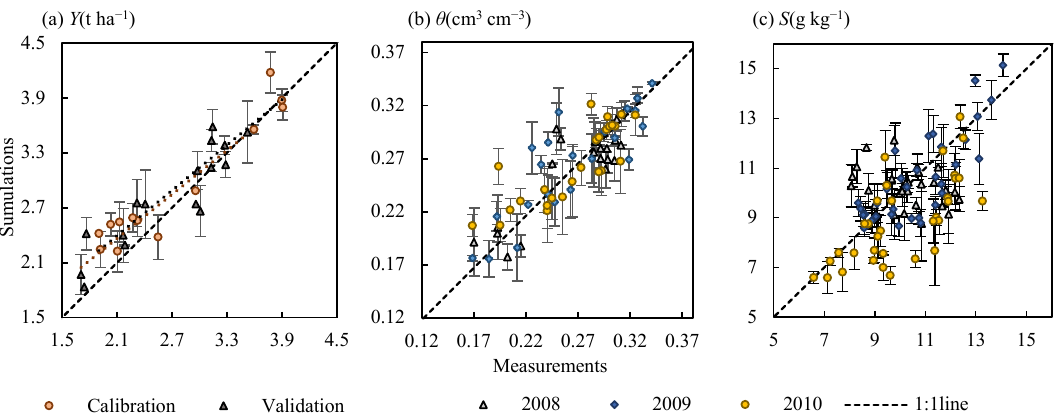
Figure 3. Modeled and measured values for comparison: ( a ) yield ( Y ), ( b ) soil water content ( θ ), ( c ) soil salt content ( S ).